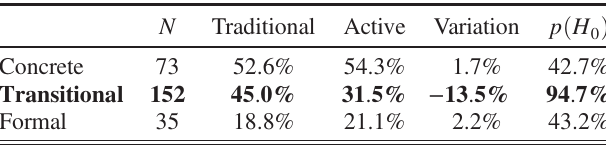
TABLE II. Failure rate in introductory physics: Global result and detail by preinstruction reasoning skills. p ð H O Þ is the probability that the failure rate decreased by introducing active learning. Bold type is used when H O is statistically likely.